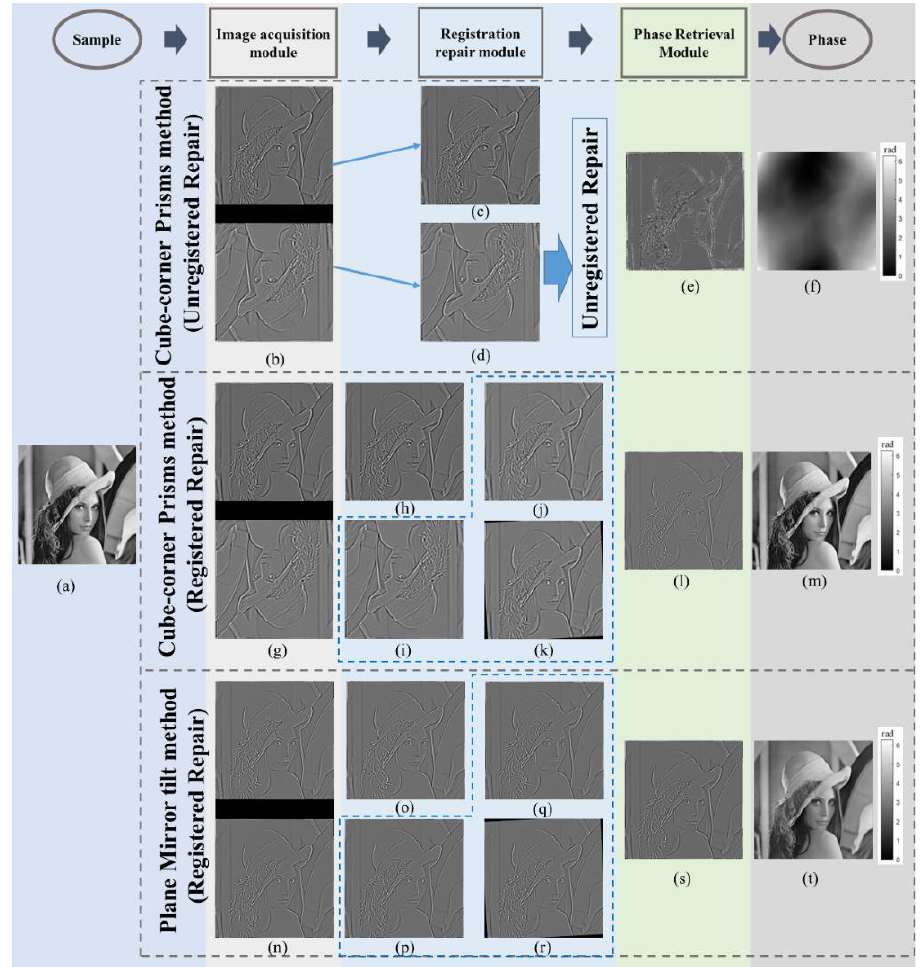
Figure 4. Simulation process and retrieval results of the cube-corner method and the plane mirror tilt method. ( a ) Selected sample; ( b – f ) The experimental process and results of the cube-corner method (unregistered repair); ( g – m ) The experimental process and results of the cube-corner method (registered repair); ( n – t ) The experimental process and results of the plane mirror tilt method (regis- tered